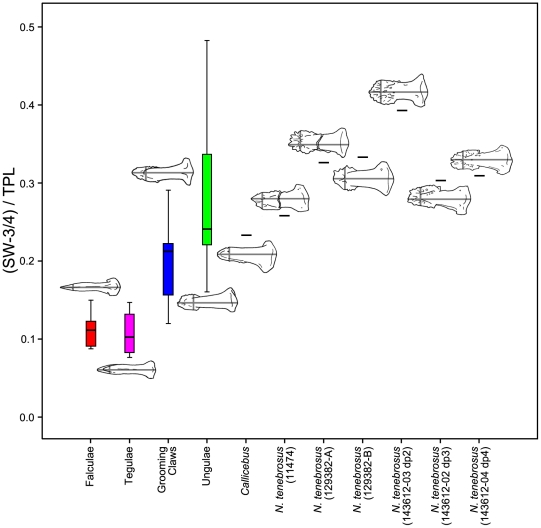
Boxplot of distal phalanx distal shaft width scaled to total phalanx length.Raw values of shaft width taken at ¾ of the length of the shaft (SW-3/4) are divided by total phalanx length (TPL). SW-3/4 and TPL are demonstrated using illustrations of specimens scaled to the same length. The median specimen from each extant group is illustrated: Tupaia glis represents the falculae group; Callithrix sp., tegulae; Galago senegalensis, grooming claws; and Saimiri sp., ungulae. See Materials and Methods for measurement descriptions.